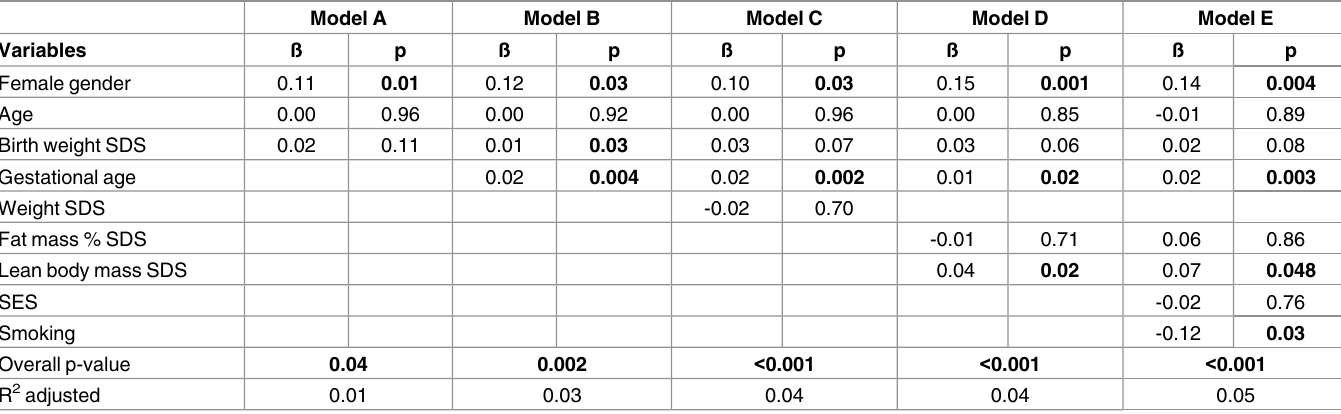
Table 3. Multiple regression analysis for variables associated with leukocyte telomere length at 21 yearsof age—Analysis including birth weight.